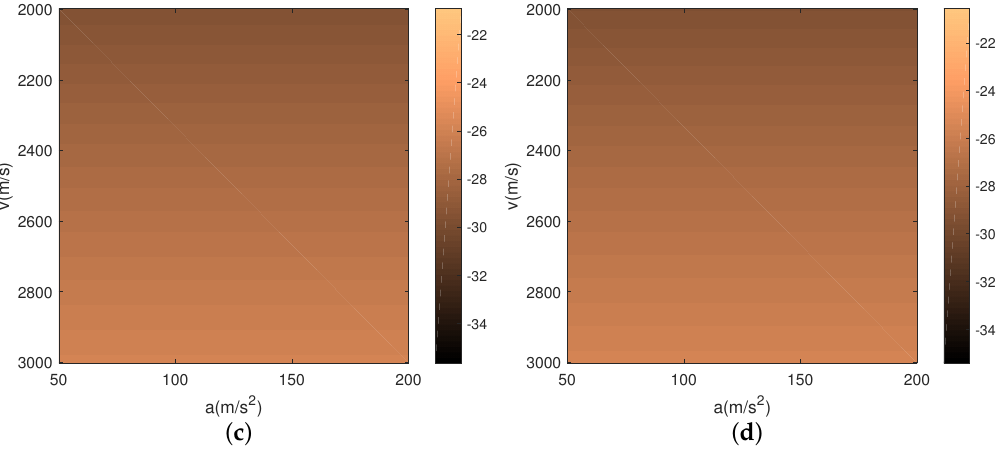
Figure 4. The PSL and I of the sequences designed by the WeCAN algorithm (dB). ( a ) The PSL of r HH, l under different motion states; ( b ) The PSL of r VV, l under different motion states; ( c ) The I of r HV, l under different motion states; ( d ) The I of r VH, l under different motion states.